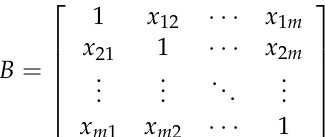
Table 2. Rules of comparison matrix. Value Meaning of the Value When Comparing Two Factors 1 Two factors are equally important 3 One factor is slightly more important than the other 5 One factor is evidently more important than the other 7 One factor is strongly more important than the other 9 One factor is extremely more important than the other 2,4,6,8 Median of two adjacent judgments mentioned above